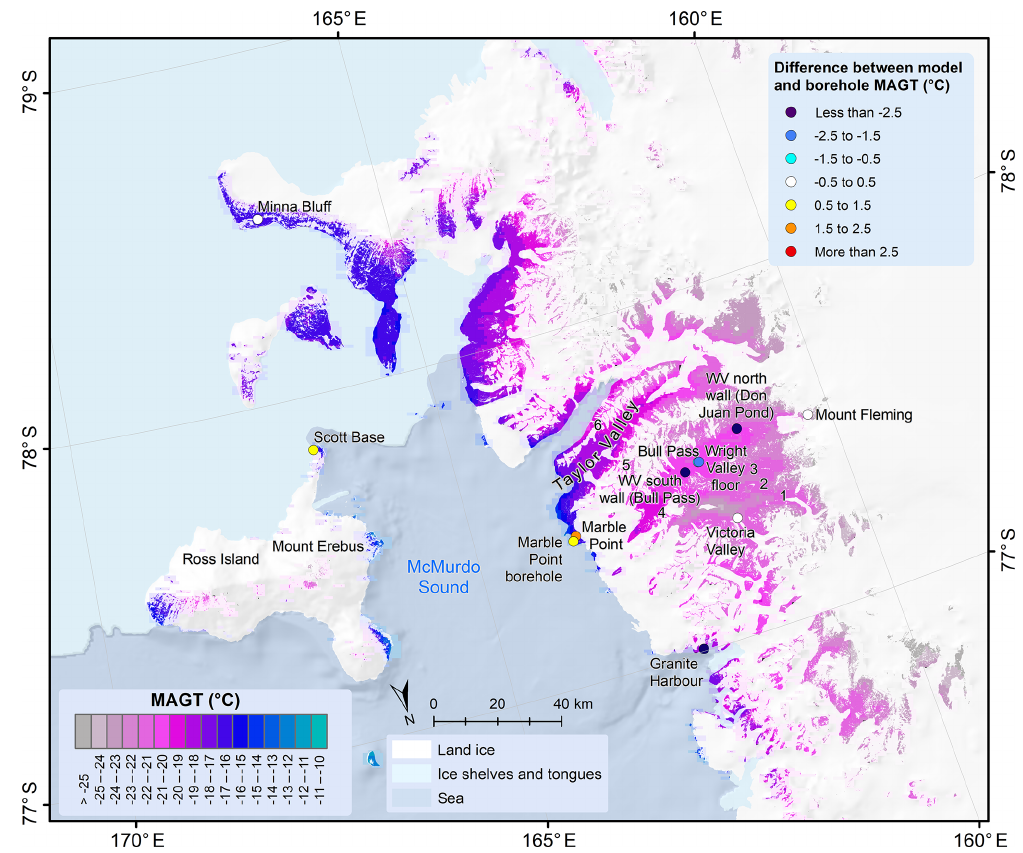
Figure 9. Permafrost temperature map of the McMurdo Dry Valleys and differences between borehole and modelled MAGT. See Fig. 1 for location. Note: the MAGT colour ramp is different from other figures. 1: McKelvey Valley. 2: Balham Valley. 3: Barwick Valley. 4: Olympus Range. 5: Asgard Range. 6: Kukri